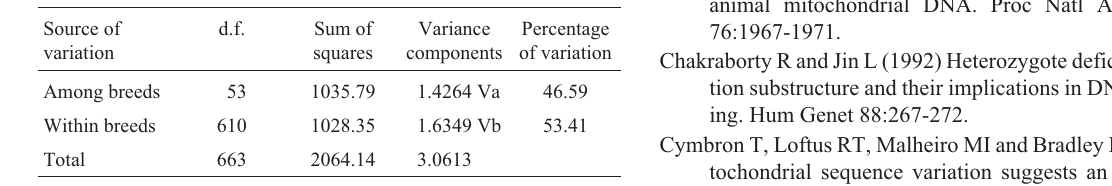
Table 4 - Hierarchical analysis of molecular variance.